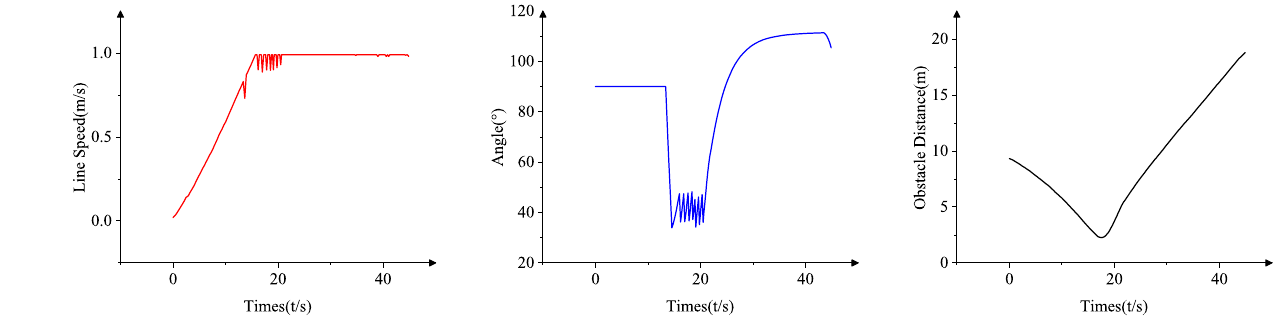
Figure 15. Parameters of the CCDWA algorithm for crossing